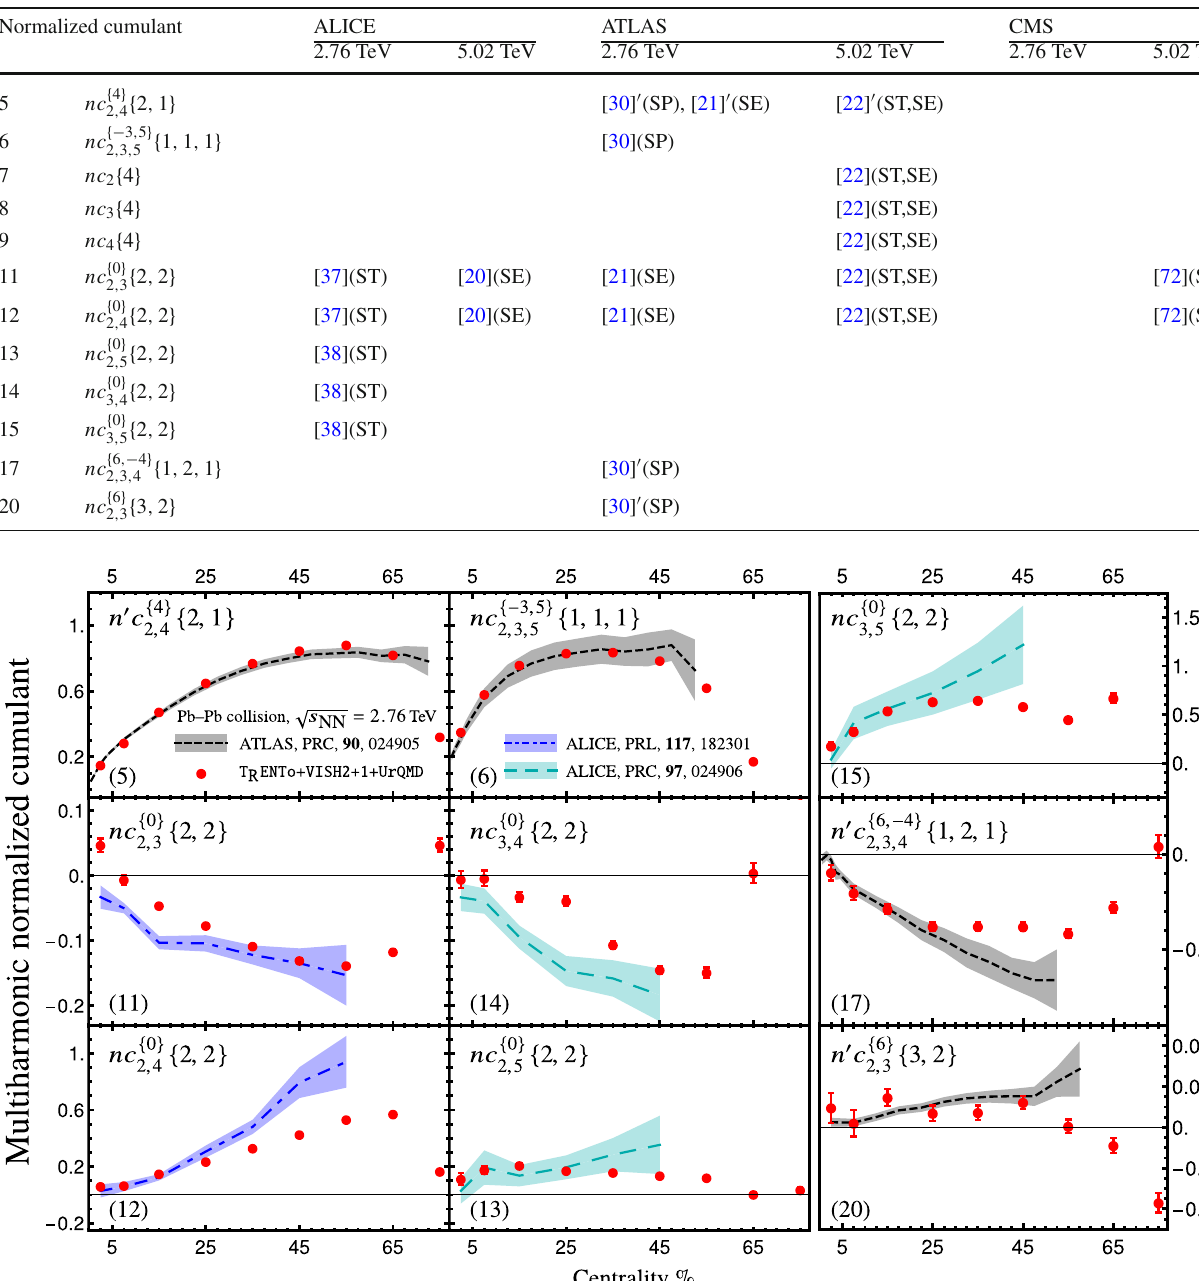
Table 2 Measured normalized cumulants at the LHC for Pb–Pb colli- sions.Thefarleftcolumnindicatesthelinenumberofthecorresponding cumulantinTable1.Inthereferencesshownby[...] (cid:10) ,thealternativever- sion of normalized cumulants (see Eq. (55)) are presented. The method